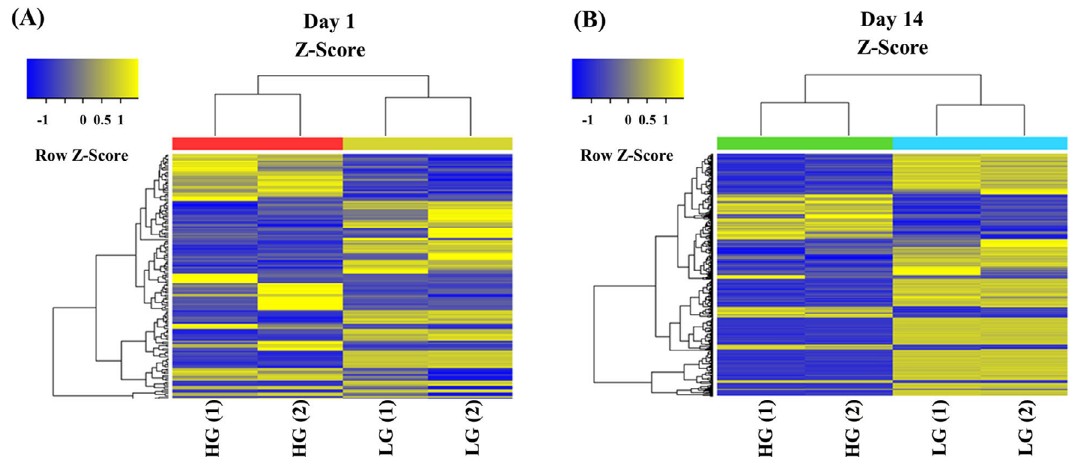
Figure 1- Hierarchical clustering heat map. Hierarchical cluster analysis displayed DEGs compared between low glucose and high glucose on day 1 (A) and day 14 (B). Low glucose (LG), High glucose (HG), sample number 1 (1) and sample number 2